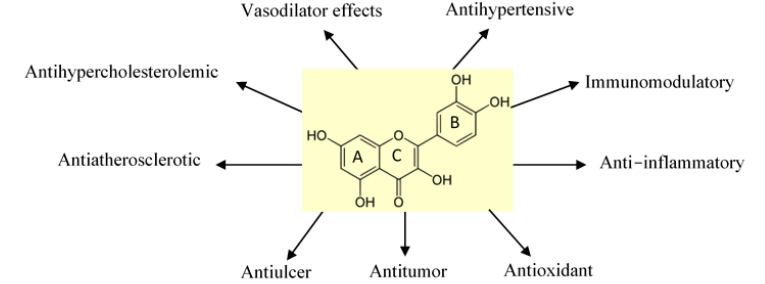
Figure 1. Biological properties of quercetin [5 – 9].